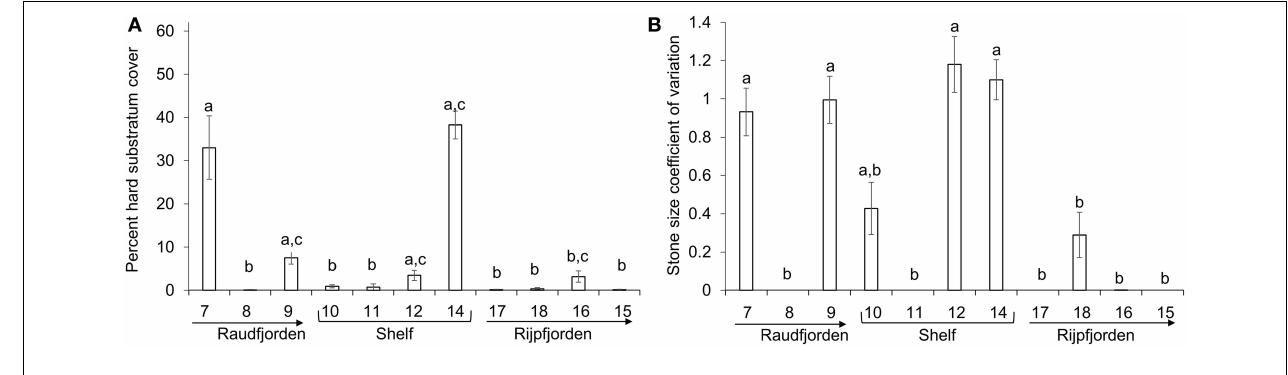
standard error. Stations without any letters in common were found to be significantly different from each other in pairwise post-hoc analysis. Arrows point toward fjord mouth.